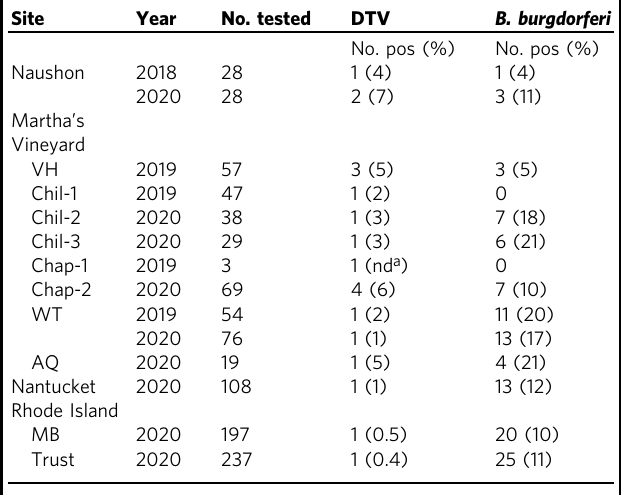
Table 2 Infection rate of deer tick virus (DTV) and Borrelia burgdorferi in ticks at each study site.